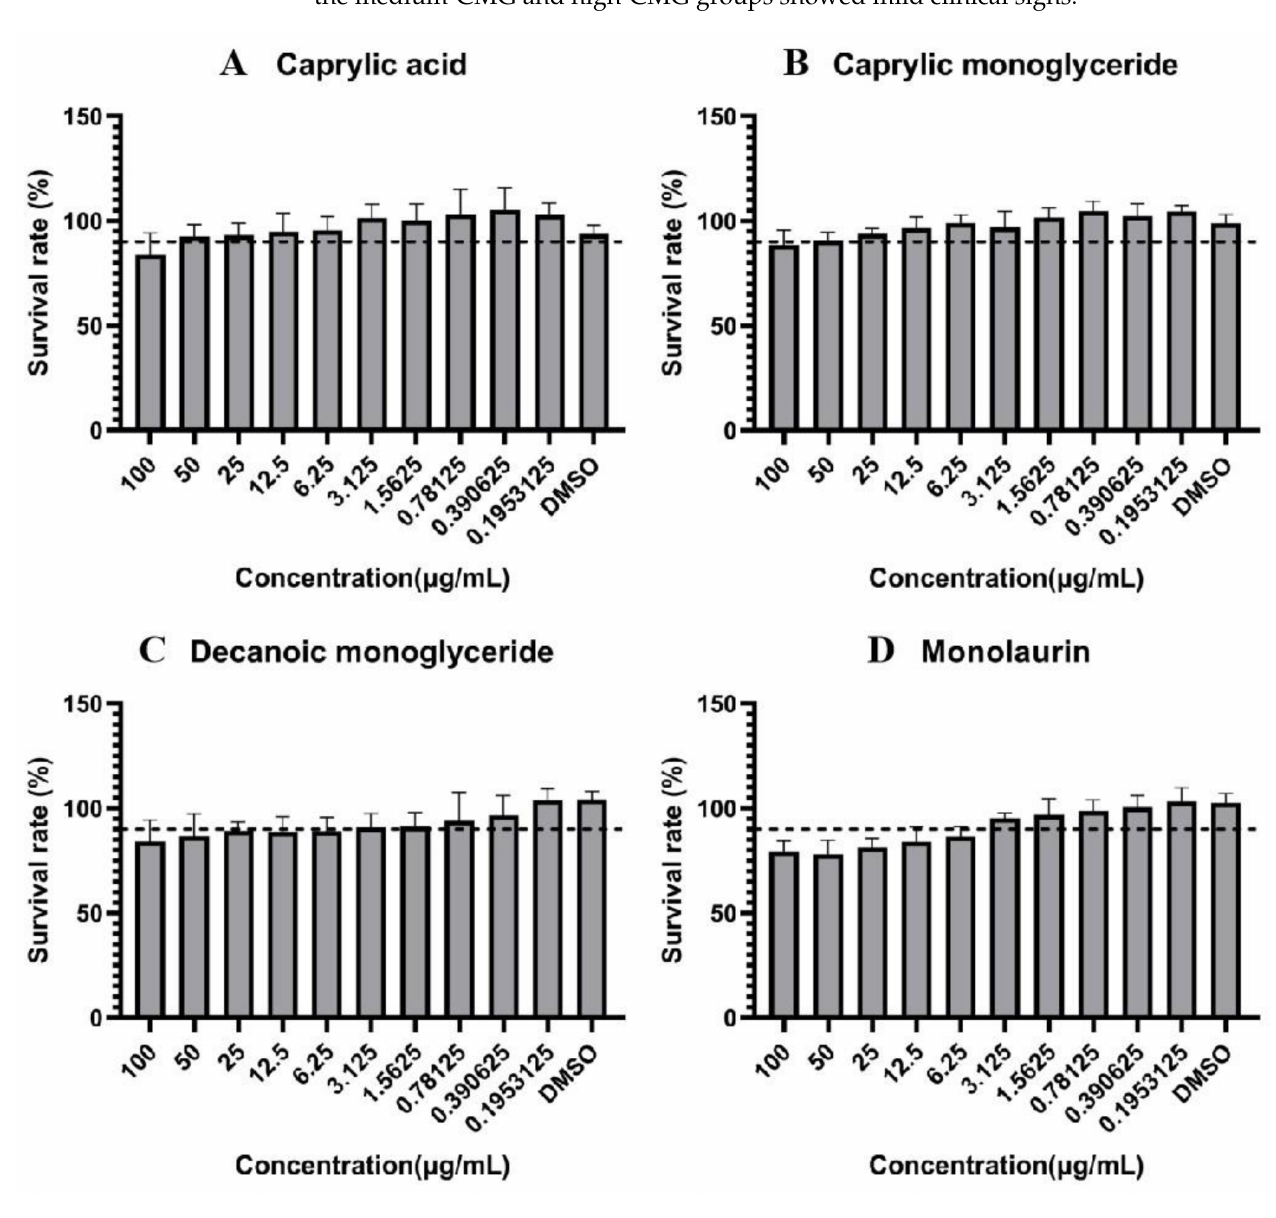
Figure 1. Survival rate of Marc-145 cells. ( A ): caprylic acid; ( B ): caprylic monoglyceride; ( C ): decanoic monoglyceride; ( D ): monolaurin. 90% survival rate as a safety scale (dashed line). The highest concentration at which cell survival rate exceeds 90% is the maximum nontoxic concentration (MNTC). Samples with solvent DMSO addition were used as a no-inhibition